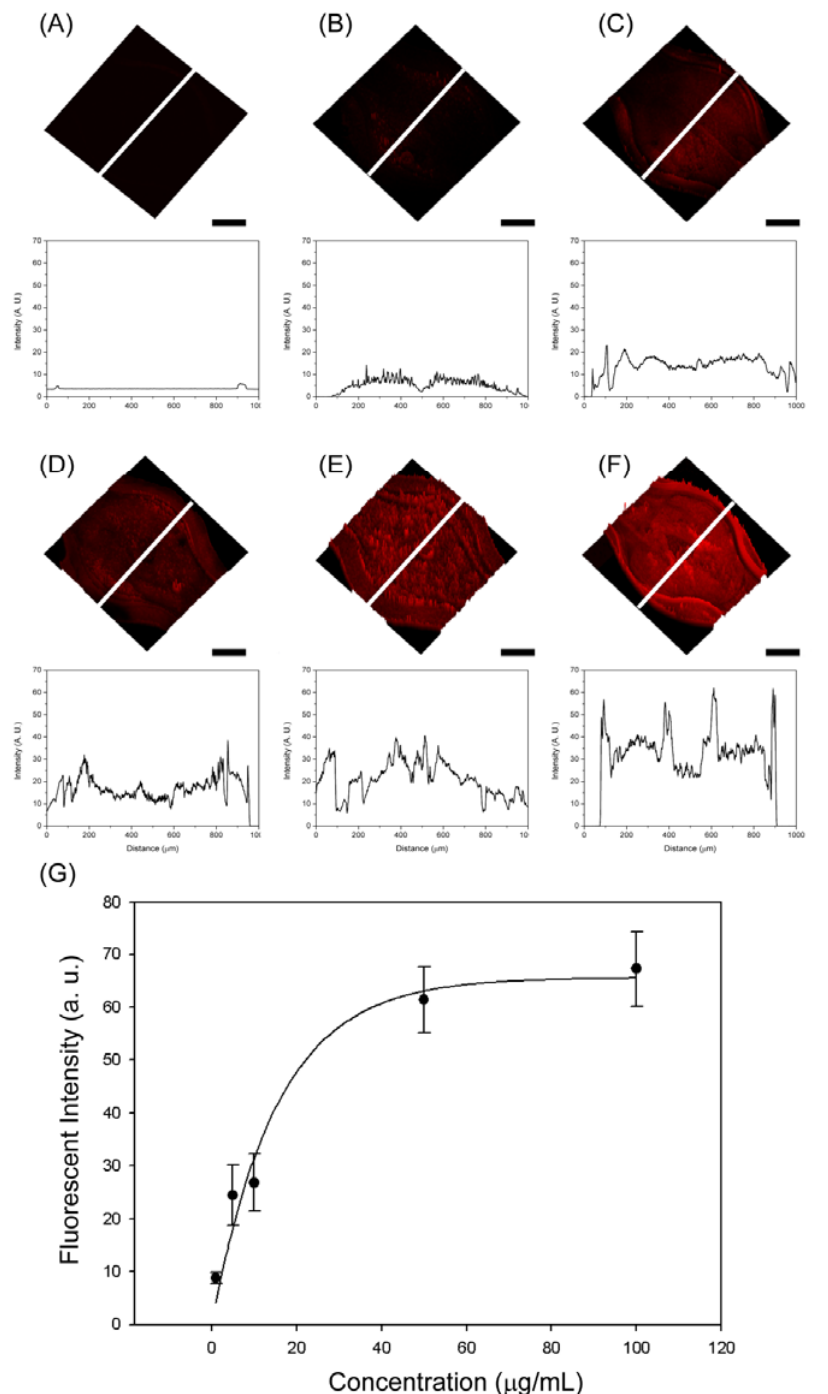
Figure 4. Fluorescent confocal microscopy images and their corresponded line profiles scanned through the center line (white color) of ( A ) control, ( B ) 1, ( C ) 5, ( D ) 10, ( E ) 50, and ( F ) 100 μ g/mL Cy3-labeled Ab immobilized on the gold surface, respectively. Scale bars represent 200 μ m. ( G ) Calibration plot for the sandwich immunoassay in a plastic-based microfluidic immunosensor